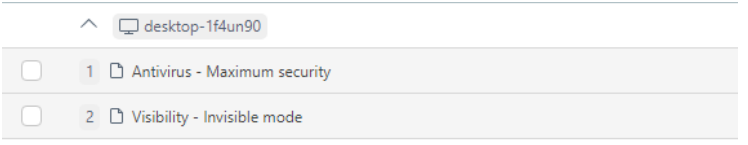
Figure 9. ESET PROTECT Enterprise settings.